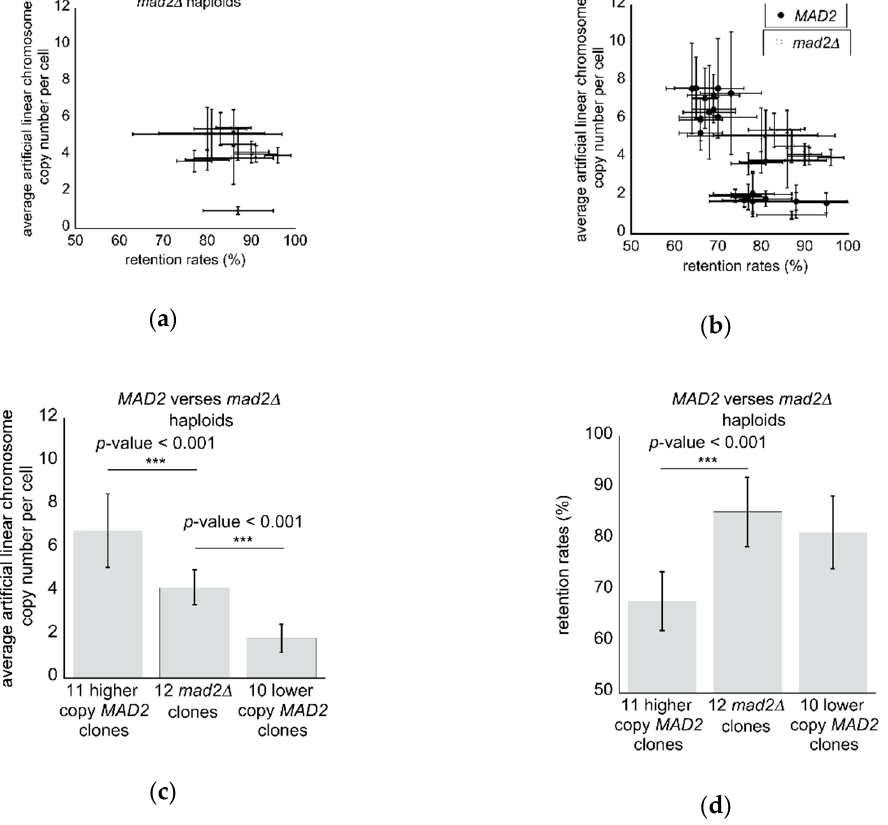
Figure 4. Mutant mad2 ∆ haploid clones display suppression of clone-to-clone differences: ( a ) The measured average artificial linear chromosome copy number per cell versus the measured retention rates ( n = 8 qPCR; n = 6 retention rate) where values are displayed as the mean ± standard deviation for 12 mad2 ∆ haploid clones; ( b ) A direct comparison between MAD2 and mad2 ∆ haploid clones of average artificial linear chromosome copy number per cell versus the measured retention rates where values are displayed as the mean ± standard deviation; ( c ) The average artificial linear chromosome copy numbers are significantly different between higher copy and lower copy clones of wild type MAD2 and the mad2 ∆ mutant clones ( p -value < 0.001 denoted by ***, Student’s t -test); ( d ) The average retention rates are significantly different between higher copy and mad2 ∆ mutant haploids ( p -value < 0.001 denoted by ***, Student’s t -test), but not between the mad2 ∆ clones and the lower copy wild type MAD2 clones.